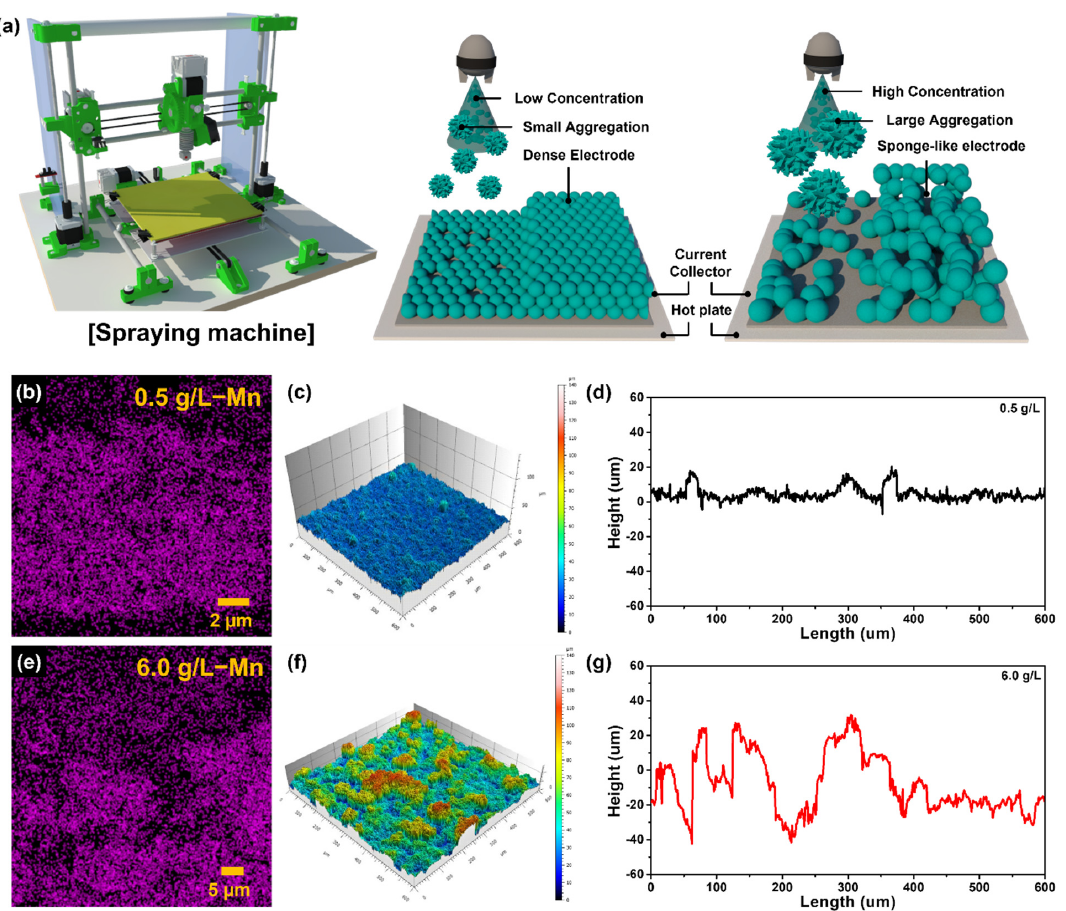
Figure 2. ( a ) Schematic mechanism of controllable engineering the Na 0.44 MnO 2 electrode structure using different suspension concentrations during the one ‐ pot spraying process, the EDS images of Mn element to visualize the cross section of electrode structures (( b ) 0.5 g/L electrode and ( e ) 6.0 g/L electrode), and the 3D surface images and the resultant height plots of ( c , d ) 0.5 g/L electrode and ( f , g ) 6.0 g/L electrode using 3D surface confocal laser scanning microscope. The galvanostatic charge/discharge voltage profiles measured at 0.1 C expose a dif ‐ ference in the electrochemical behavior among the electrodes (Figure 3a). Compared to the dense electrode structure made by the suspension concentration of 0.5 g/L, the charge/discharge profiles of the electrodes made by the higher suspension concentrations show six more distinct plateaus, indicating the consecutive phase transitions of Na 0.44 MnO 2 during Na ‐ ion intercalation and deintercalation [46], especially for the elec ‐ trode made by the suspension concentration of 6.0 g/L, resulting in the maximum of the initial discharge capacity (121.6 mAh/g). This is attributed to the open channels within the electrode providing an effective surface area for the electrochemical reactions of the Na ions with the Na 0.44 MnO 2 active material [32]. Furthermore, as shown in Figure 3b,d, while the 0.5 g/L electrode shows rapid degradation of the specific capacity at the accelerated current densities from 0.1 to 10 C, the 6.0 g/L electrode exhibited superior capacity value and capacity retention at increasing C rates to 10 C. The 6.0 g/L electrode also exhibited higher volumetric capacities at 1 C and higher rates (Figure 3c), which can be attributed to the improved anodic diffusion coefficient of the Na ion ( D , cm 2 /s, Figure 3e) that is de ‐ rived by a linear relation based on peak current ( I p , mA) and scan rate ( ν ) based on the